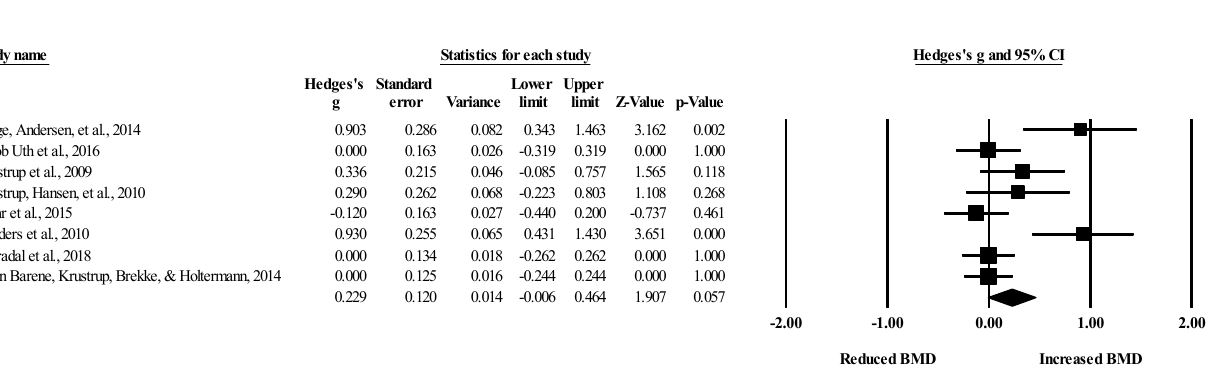
Figure 5. Funnel plot for changes in total body bone mineral density in untrained adults after a training program based on soccer small-sided games compared to an active control condition. White circles: observed studies. Eight studies provided data for total body BMD, involving eight experimental groups (pooled n = 151). Results showed a small effect of SSGs on total body BMD (ES = 0.23; 95% CI = − 0.01 to 0.46; p = 0.057; I 2 = 70.2%; Egger’s test p = 0.009; Figure 6). After the Trim and Fill method was applied, the adjusted values remained equal to the observed values. For the assessment of publication bias, a funnel plot is presented in Figure 7.